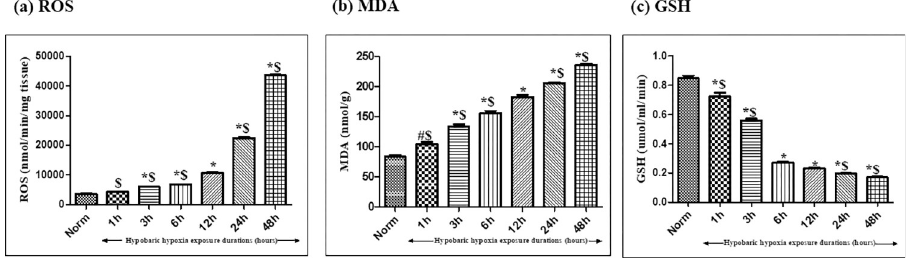
Fig 1. Effect of hypobaric hypoxia exposure on oxidative stress parameters in kidneys of rats exposed to 7620 m (25,000 ft.) at 25 ± 2˚C for different time durations (i.e. Normoxia control (0h), 1h, 3h, 6h, 12h, 24h and 48h).